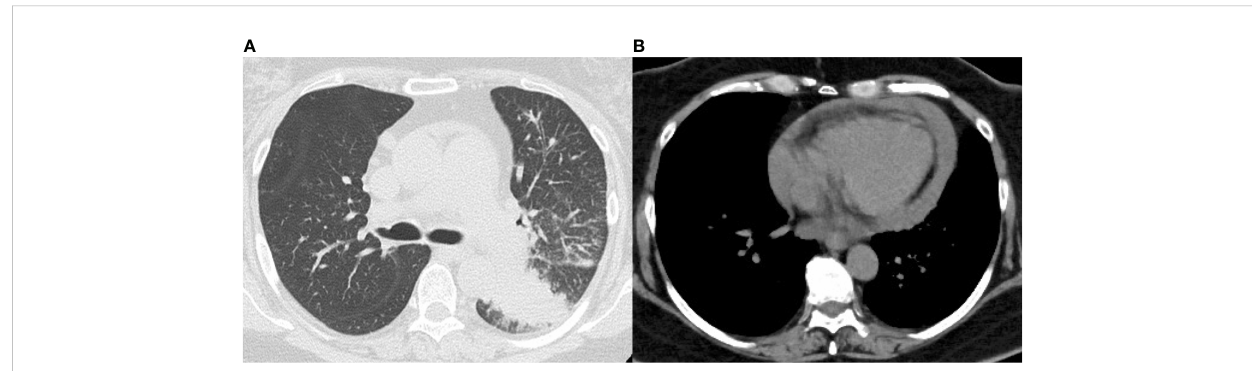
FIGURE 1 Chest computed tomography on admission. (A) Lung window shows a mass shadow in the lower lobe of the left lung. (B) Mediastinal window shows pericardial